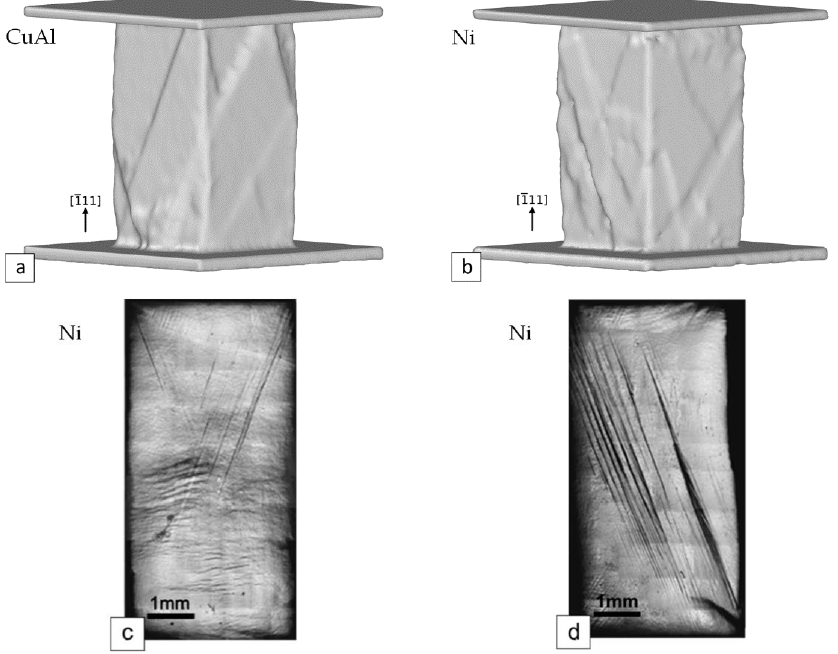
(cid:2) (cid:3) 111 single crystals: ( a ) CuAl ( ε = 11.2%) and (cid:2) (cid:3) 111 nickel single crystal,